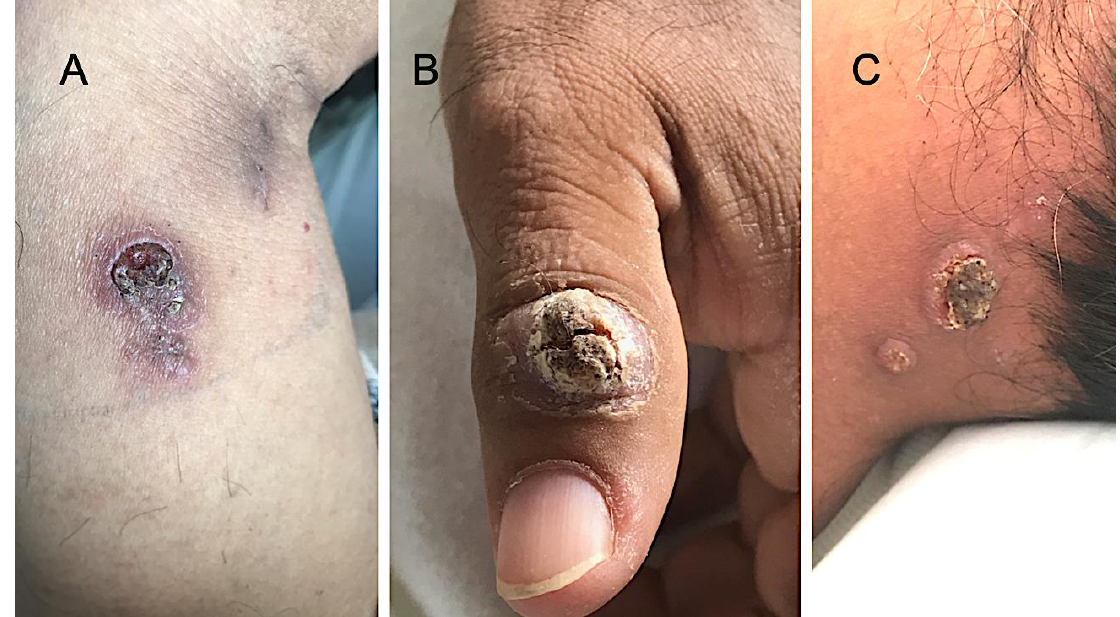
Figure 3. Skin lesions of the patient: ( A ) verrucous plaque of right forearm (the biopsy site); ( B ) large verrucous lesion of the left thumb; ( C ) nodular and verrucous lesions of the nape of the neck.